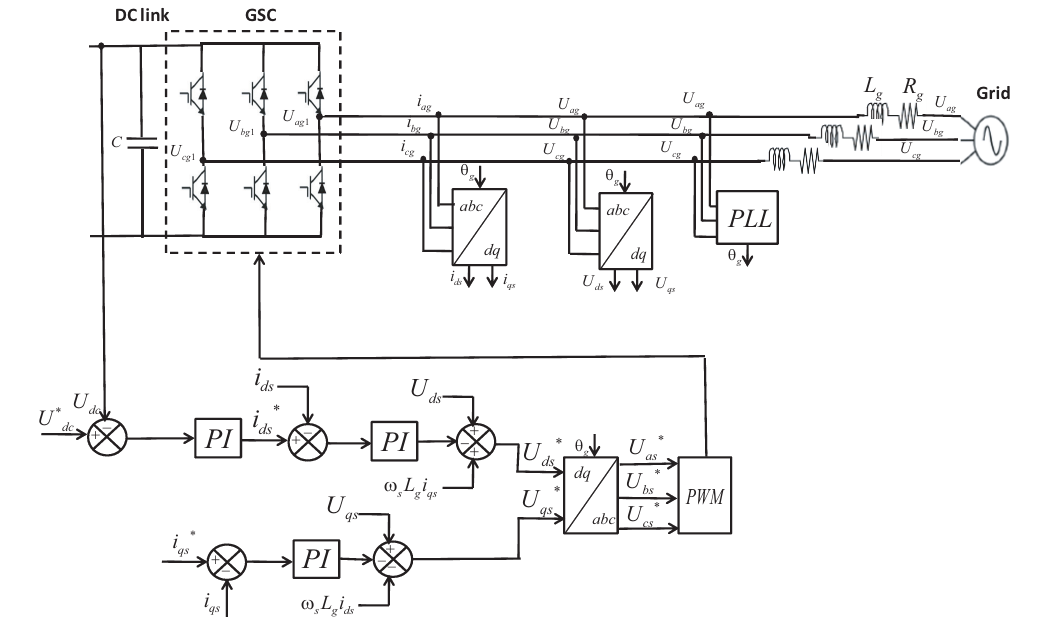
Figure 11. Voltage oriented control strategy for the